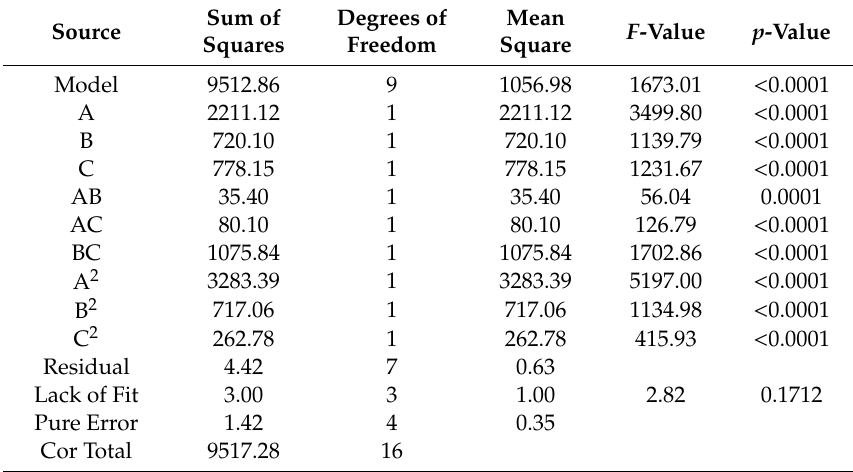
Table 3. Analysis of variance (ANOVA) for the quadratic